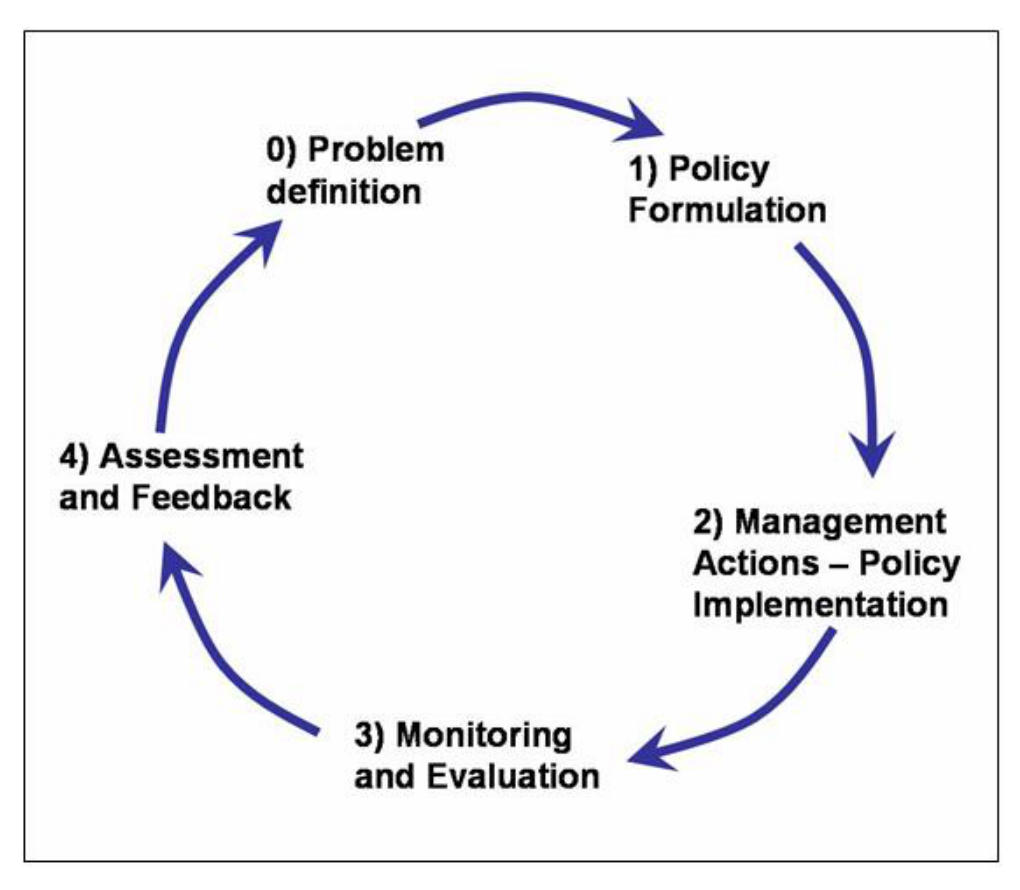
Fig. 2 . Iterative cycle of policy development and implementation in adaptive